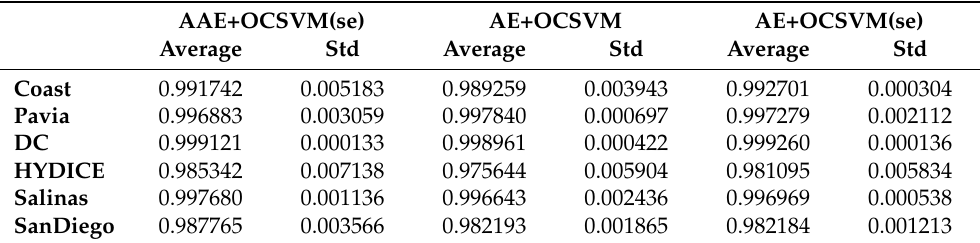
Table 8. AUC f of OCNN, OCNN_S, OCNN_NL, and SAOCNN_NA in repeated